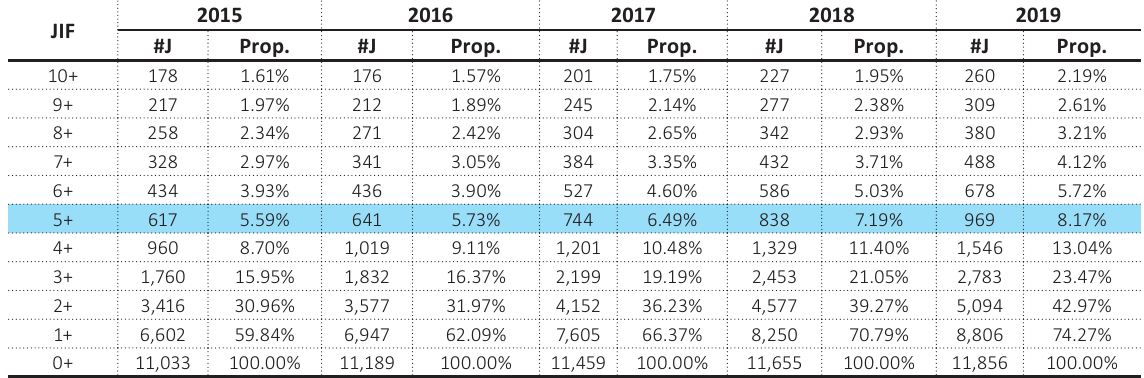
Table 2. Cumulative numbers of journals against progressive JIF levels